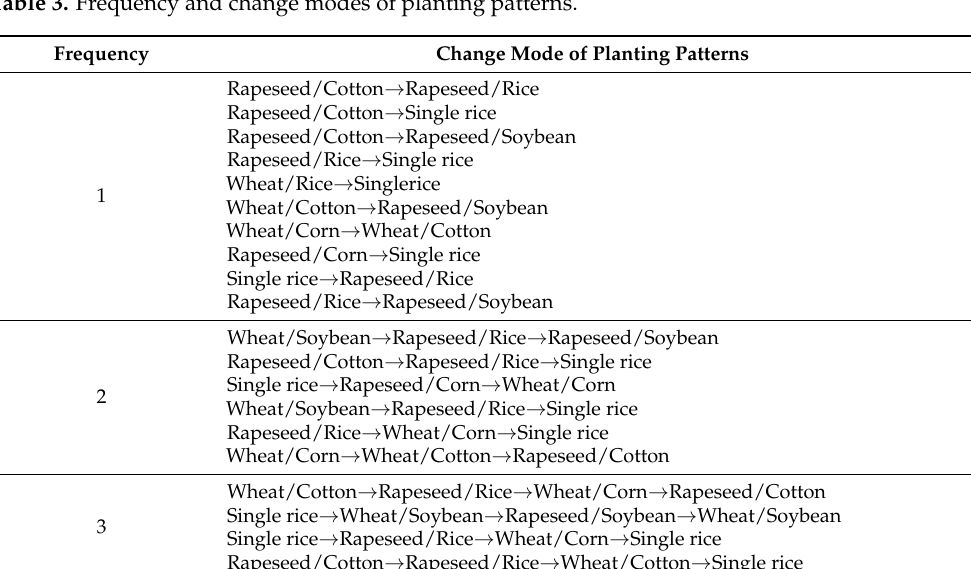
Figure 10. Frequency of change of planting pattern. Table 3. Frequency and change modes of planting patterns.